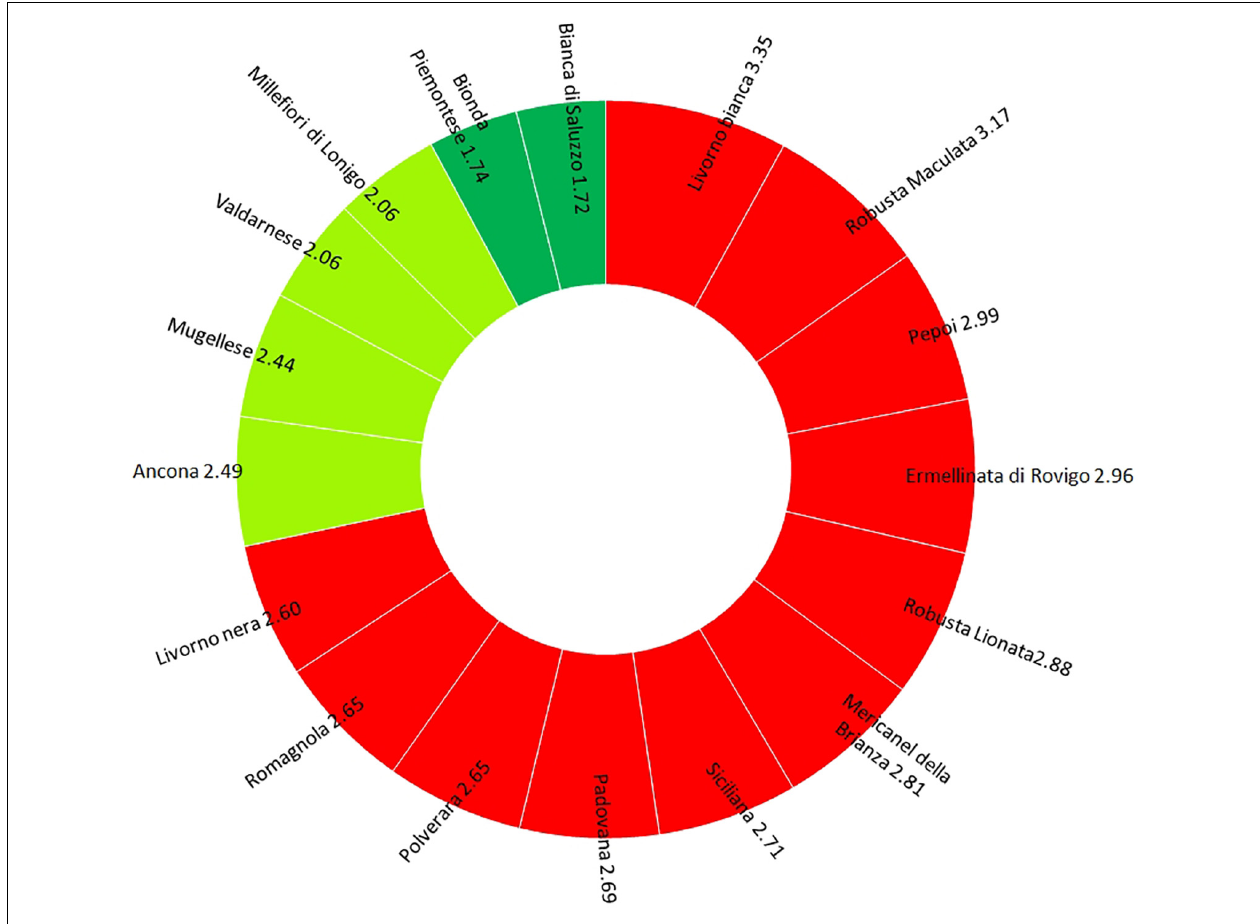
FIGURE 4 | Graphical output of Extinction Risk Index (ERI): breeds with ERI > 2.5 (red), breeds with ERI = 2–2.5 (light green), and breeds with ERI < 2